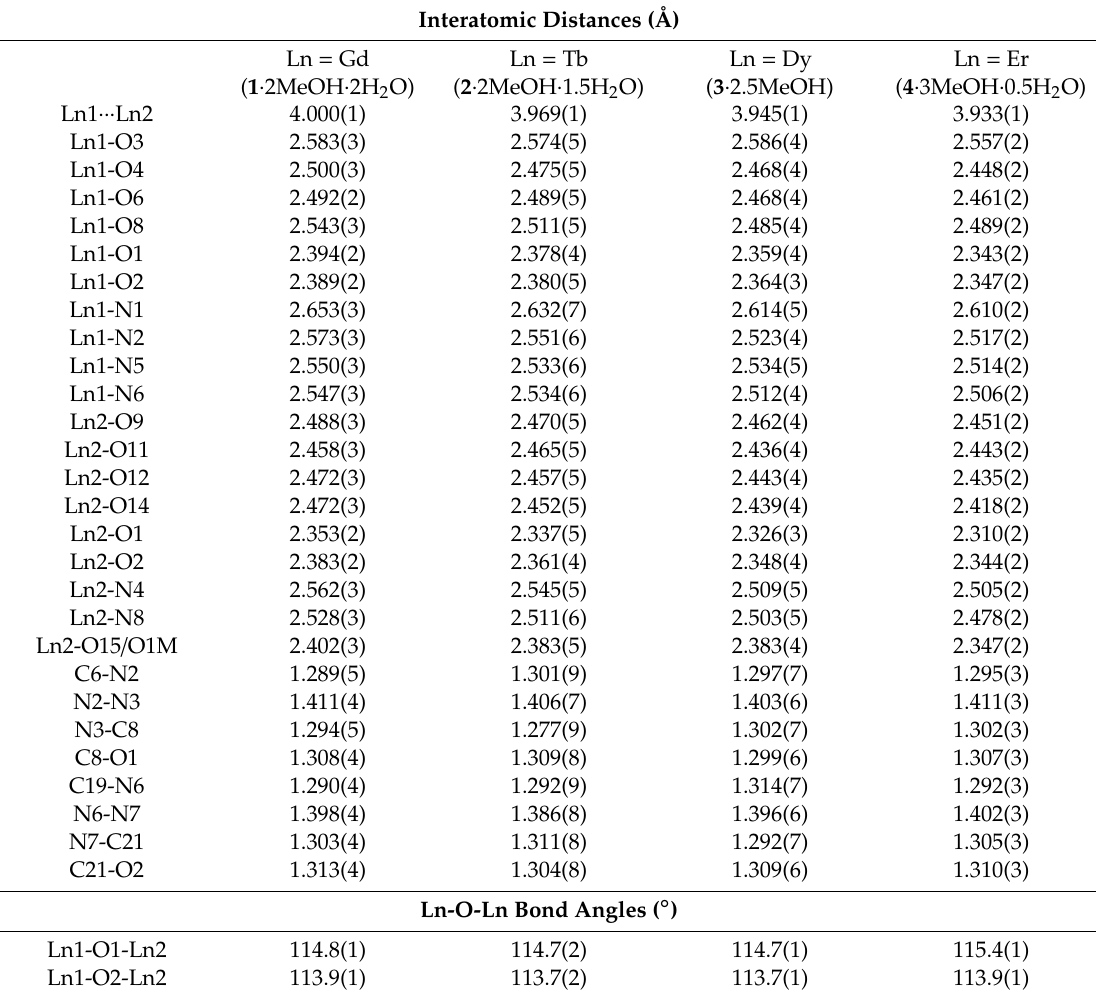
Table 2. Selected interatomic distances (Å) and the Ln-O-Ln bond angles ( ◦ ) in